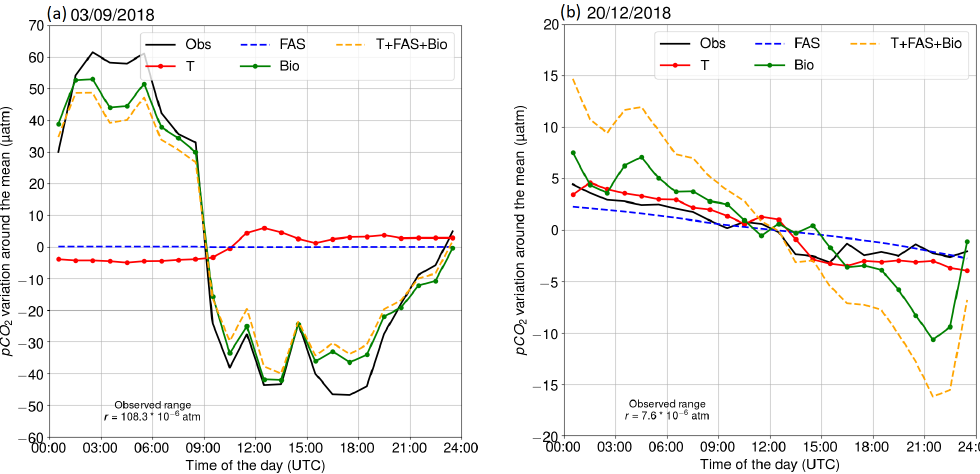
Figure 4. Diurnal p CO 2 variability on (a) 3 September 2018 and (b) 20 December 2018. The black line is the observed (Obs) evolution. Other lines represent the calculated p CO 2 evolution, driven by different processes: red indicates temperature ( T ), blue indicates the air–sea exchange of carbon dioxide (FAS), green indicates biological transformations (Bio), and orange indicates the combined effect of all processes ( T + FAS + Bio).